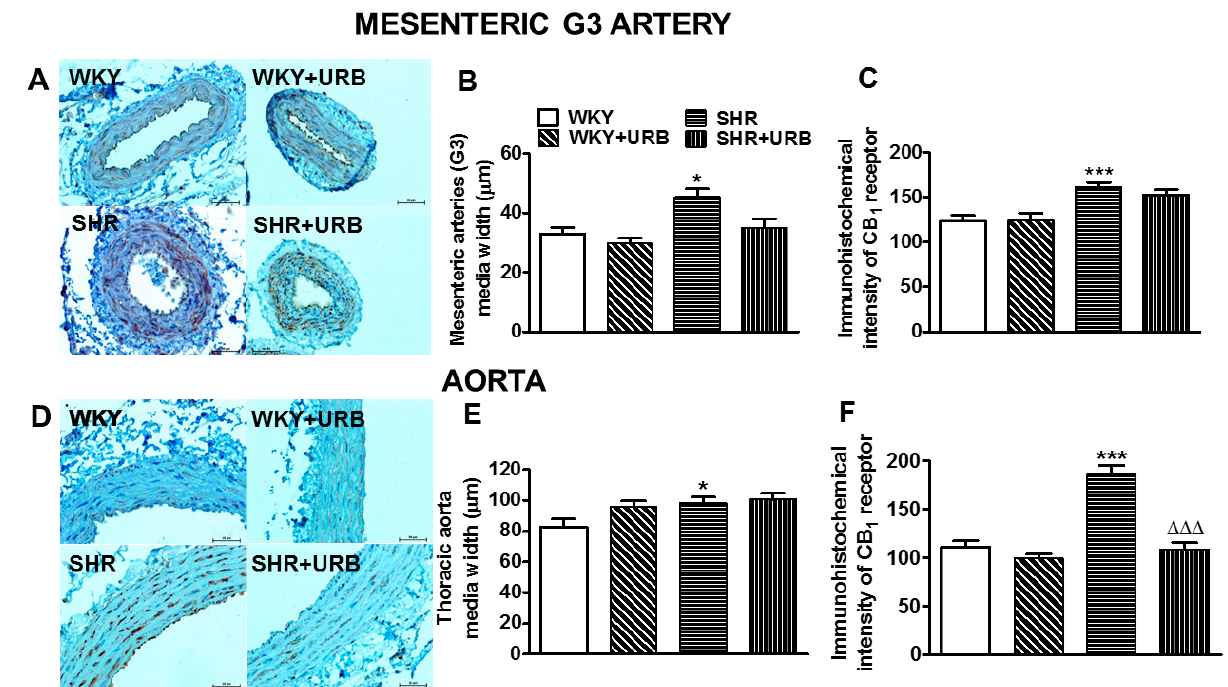
Figure 5. Representative micrographs of the vascular remodeling and immunohistochemical staining of CB 1 receptors in cross-sections in the mesenteric G3 arteries ( A ) and aortic wall ( D ) from normotensive rats—control (WKY) and URB597- treated (SHR + URB). H + E staining. The bar graph illustrates the measured mesenteric G3 arteries ( B , C ) and aortic ( E , F ) medial widths and the intensity of the immunohistochemical reactions for the CB 1 receptors, respectively. URB597 at 1 mg/kg or its vehicle was injected intraperitoneally every 12 h for 14 days. Mean ± SEM of n = 5 tissues for each bar; * p < 0.05 and *** , ∆∆∆ p < 0.001 compared to the respective control groups (* WKY or ∆ SHR); bar = 50 µm.